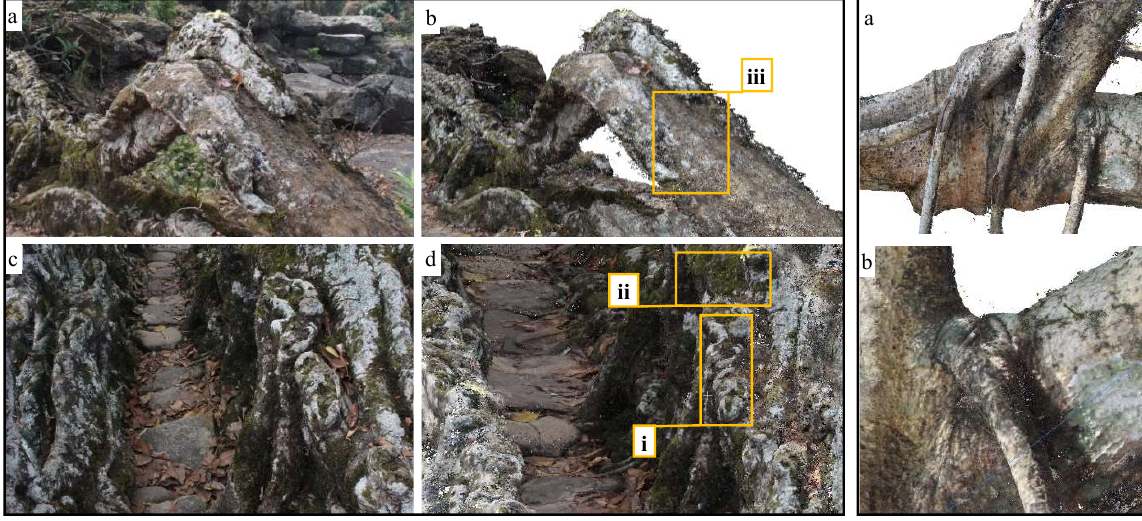
Figure 5: An inosculation provides water transport (a),